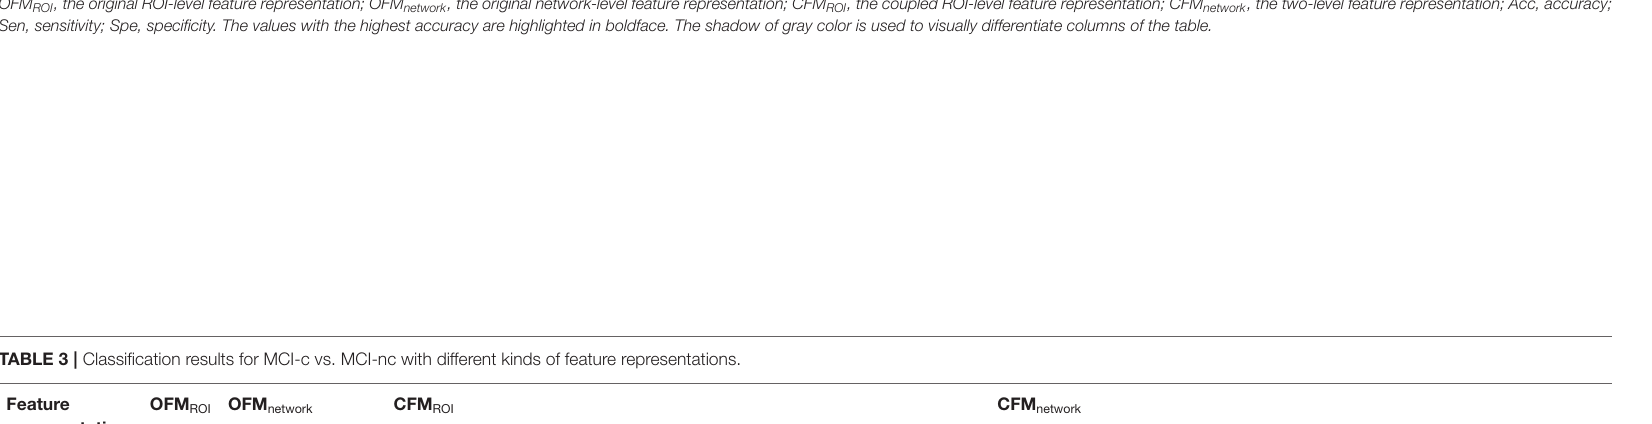
TABLE 3 | Classification results for MCI-c vs. MCI-nc with different kinds of feature representations. Feature OFM ROI OFM network CFM ROI CFM network representation Parameters